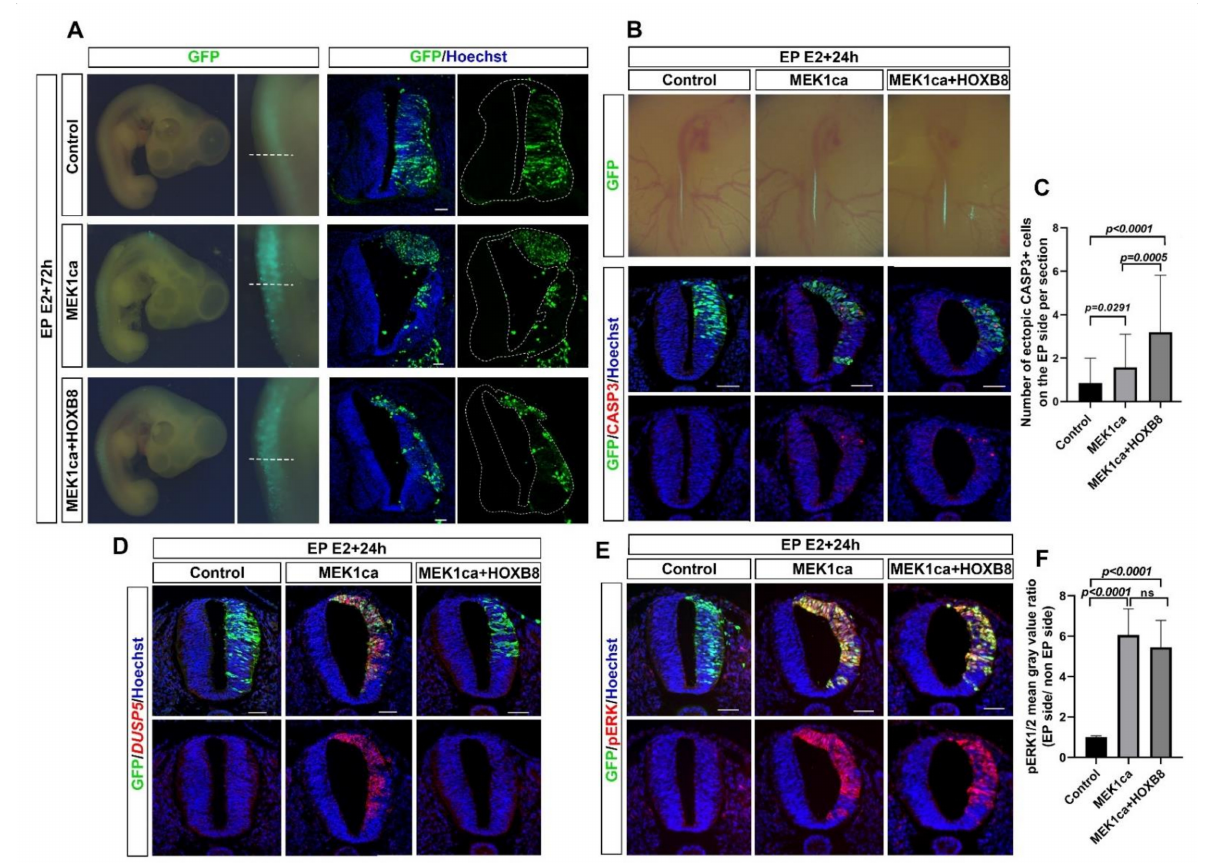
Figure 1. HOXB8 suppresses MEK1ca-induced neoplasia in the trunk neural tube. ( A ) Dorsal view of electroporated embryos three days post-electroporation with the control pCIG-, MEK1ca-, or MEK1ca + HOXB8-expressing vectors. Transfected cells are identified by GFP and immunofluorescence staining on the corresponding transverse sections (white dotted lines) of the chicken embryo with the anti-GFP antibody three days post-electroporation with the pCIG-, MEK1ca-, or MEK1ca + HOXB8- expressing vectors. ( B ) Top: Dorsal view of electroporated embryos one day post-electroporation with the control pCIG-, MEK1ca-, or MEK1ca + HOXB8-expressing vectors. Transfected cells are identified by GFP. Bottom: Immunofluorescence staining on transverse sections of chicken embryo with anti-GFP and anti-cleaved caspase 3 (CASP3) antibodies. ( C ) Number of ectopic CASP3+ cells on the electroporated side one day after electroporation in the three conditions ( n = 3 animals/18 sections). The quantifications show a significant increase of Casp3+ cells in the neural tube after MEK1ca and MEK1ca + HOXB8 conditions compared to control, with more Casp3+ cells in the MEK1ca + HOXB8 condition than in MEK1ca alone (two-tailed Mann–Whitney test, error bars represent the SD). ( D ) Fluorescence in situ hybridization with the DUSP5 probe and immunofluorescence staining with the anti-GFP antibody on transverse trunk sections of chicken embryo one day post-electroporation in the three conditions. ( E ) Immunofluorescence staining on transverse sections with anti-pERK1/2 and anti-GFP antibodies one day post-electroporation with the pCIG-, MEK1ca- or MEK1ca + HOXB8-expressing vectors. ( F ) one day after electroporation in the three conditions: pERK1/2 mean gray value ratio (electroporated/contralateral side) ( n = 3 animals/18 sections). The quantifications show no significant difference between the MEK1ca and MEK1ca + HOXB8 conditions (two-tailed Mann–Whitney test, error bars represent the SD). Blue is Hoechst staining. Scale bar: 50 µ